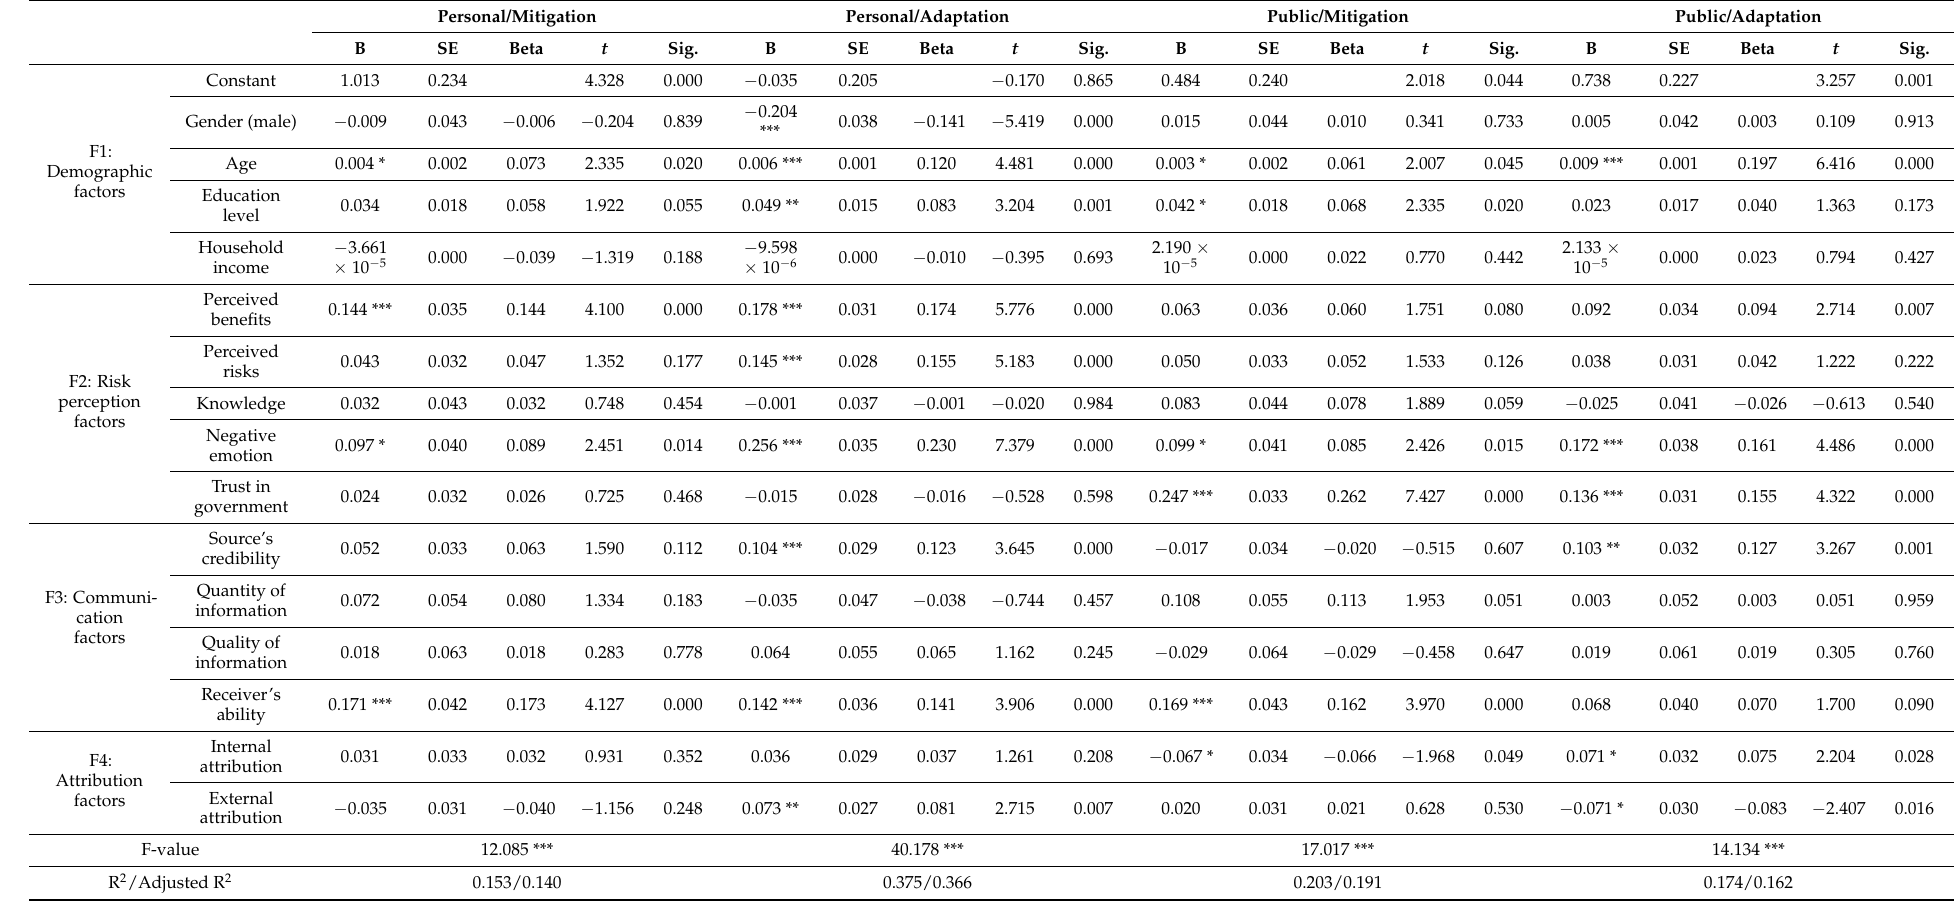
Table 6. Multiple regression analysis for actions against